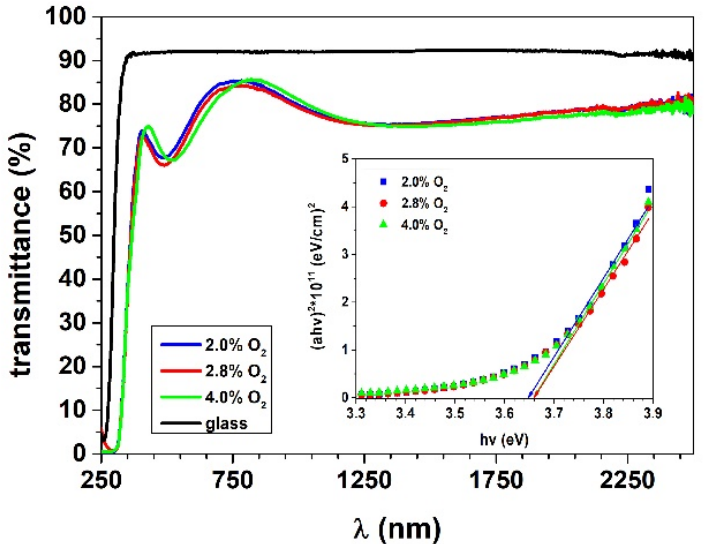
Figure 4. Transmittance spectra of rf-sputtered NiO:Al films grown at room temperature with different O 2 content in plasma that underwent thermal annealing at 400 °C for 24 h. Inset: Tauc plot to determine the optical energy band gap of the films.